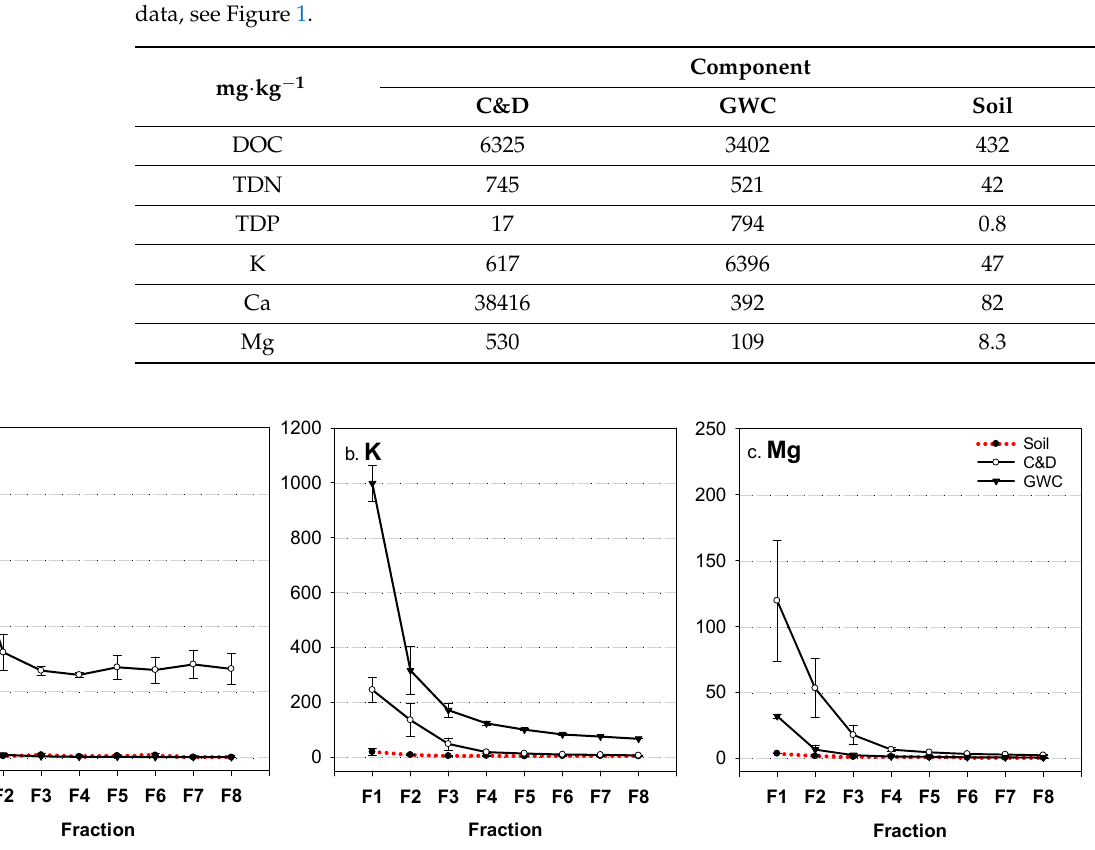
Figure 1. Column leaching experiment showing concentrations of ( a ) Ca, ( b ) K and ( c ) Mg in leachates (mg L − 1 ) from the individual components of the technosols and soil. Each fraction “F” indicates an increment in time (see method). Values are mean of duplicate columns (error bars +/ − S.E.M). For total accumulate removal data, see Table 2. Table 2. Total accumulated removal of dissolved organic carbon (DOC), total dissolved nitrogen (TDN), total dissolved phosphorus (TDP) and other selected elements as determined by the col- umn leaching test (mg·kg − 1 ). Values are mean of duplicate columns; for selected leachate concen- tration data, see Figure 1.